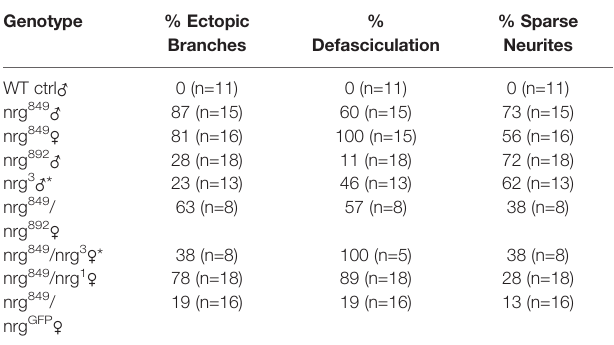
FIGURE 3 | Complementation analysis of nrg alleles in IPC neuron development. Compared to (A) wildtype adult IPCs, (B, C) nrg 849 mutants display ectopic branches, median bundle defasciculation, and loss of lateral neurite complexity (asterisk in B). (D-I) Similar phenotypes can be seen in nrg 892 and nrg 3 hemizygous males, and nrg 849/1 , nrg 849/892 , nrg 849/3 , and nrg 849/GFP transheterozygous females. Flies with the temperature-sensitive nrg 3 allele were raised at the permissive temperature of 18°C and shifted to the restrictive temperature of 29°C as wandering 3 rd instar larvae. IPCs were visualized using Dilp2-GAL4 >GFP-CD8. Scale bar = 50 m m. TABLE 1 | Complementation analysis of nrg